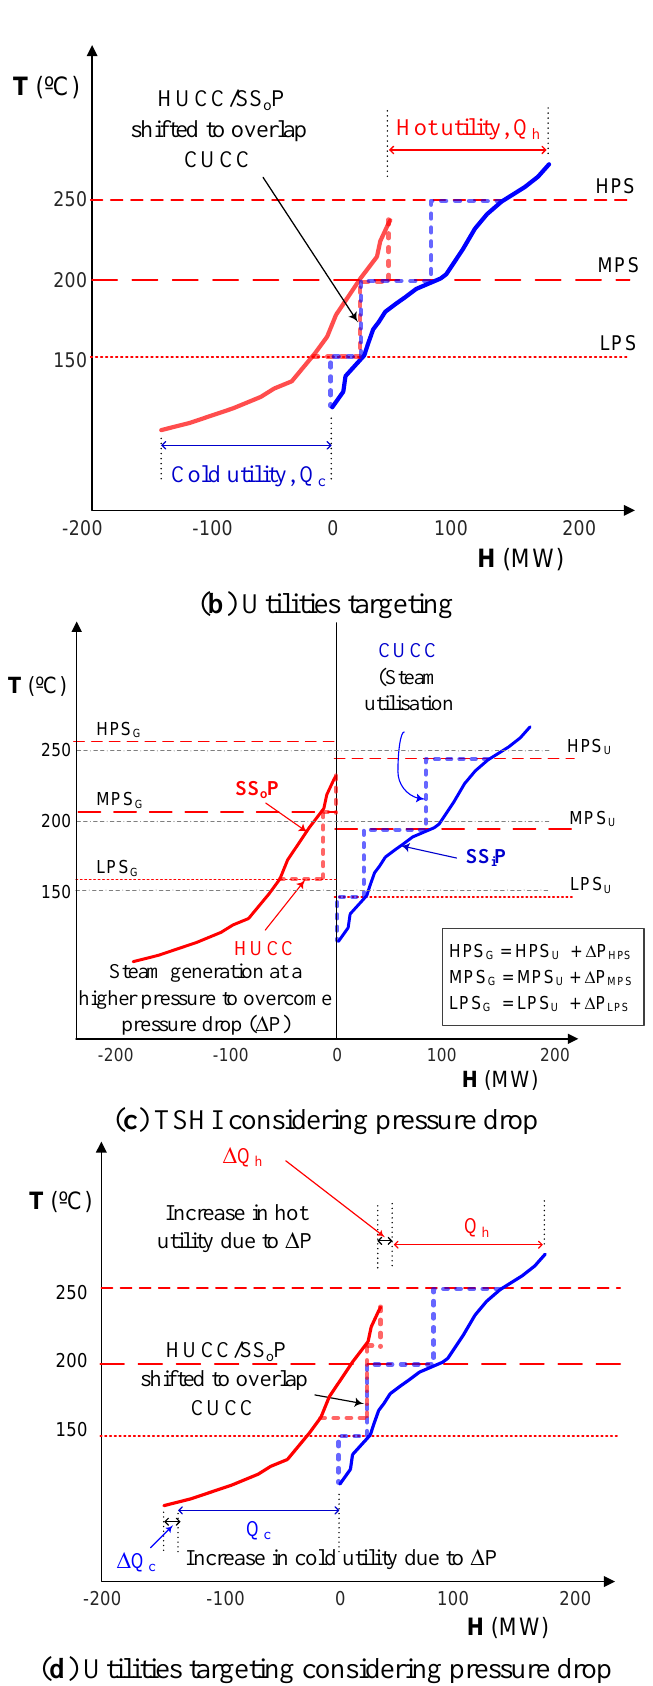
Figure 1. TSHI utilities targeting (adapted from Klemeš et al.